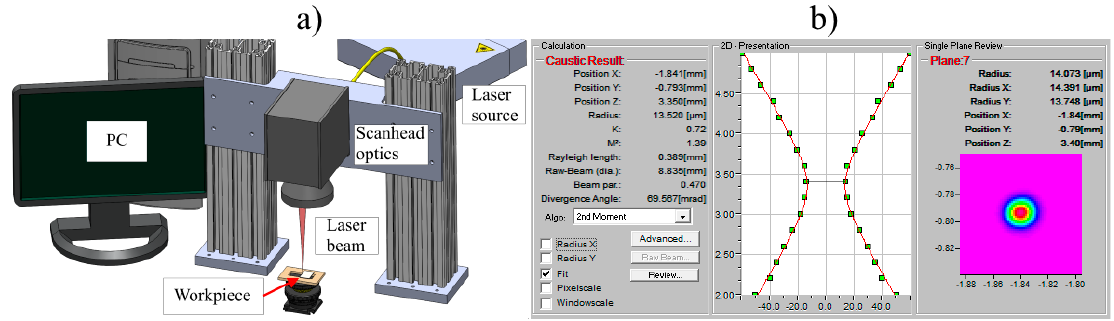
Figure 1. ( a ) A schematic illustration of the experimental setup. ( b ) Tested optical properties of the laser beam.